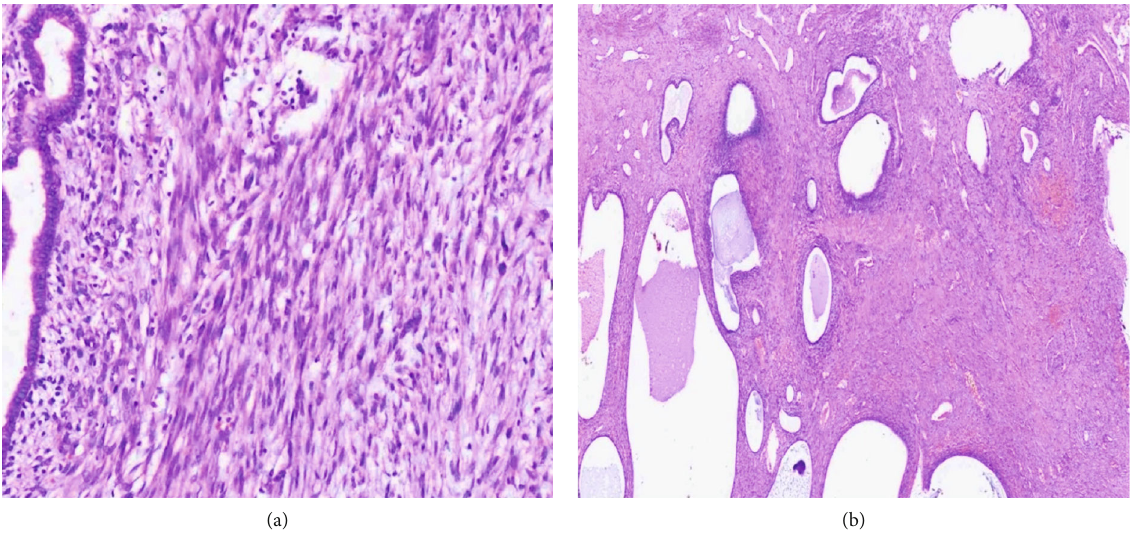
Figure 4: Histological section reveals (a) interlacing fascicles of bland spindle cells with adjacent glandular structures suggestive of a leiomyoma with focuses of adenomyosis and (b) cystically dilated glands of di ff erent sizes lined by bland columnar cells in muscular stroma suggestive of